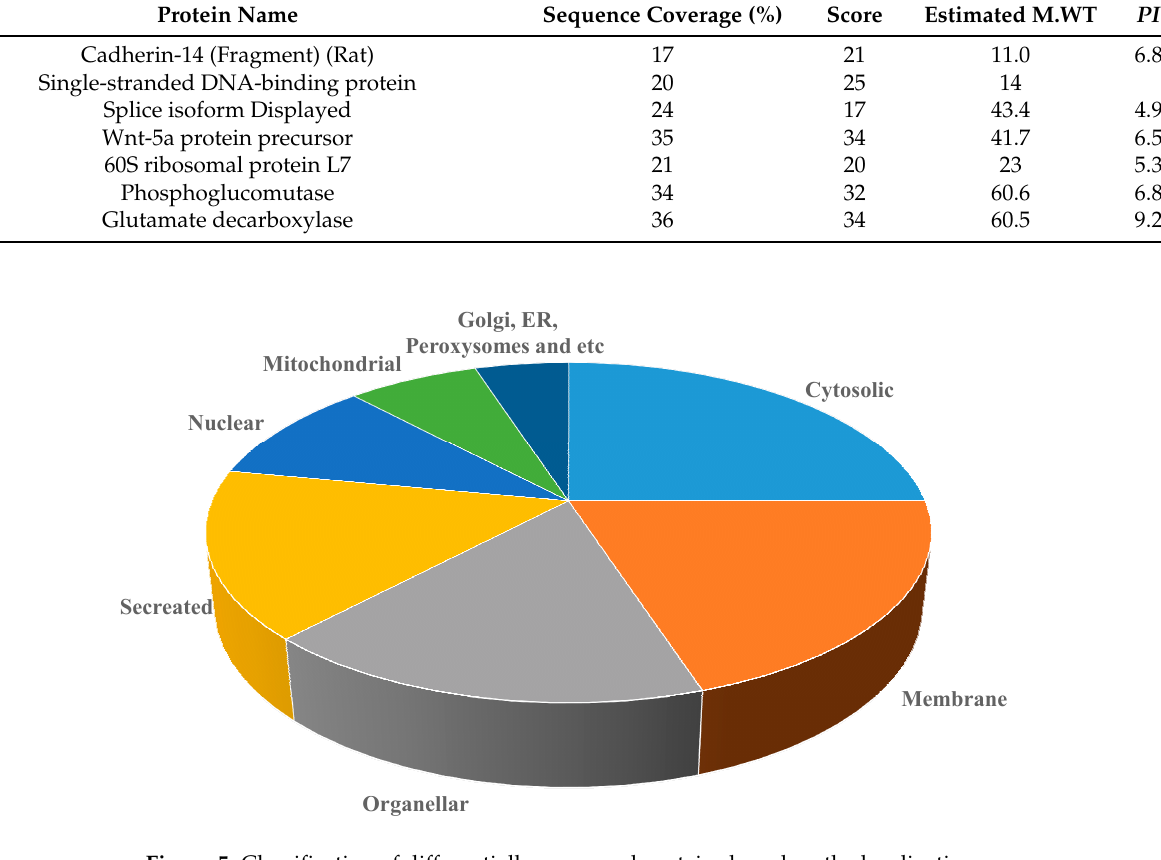
Figure 5. Classification of differentially expressed proteins based on the localization.